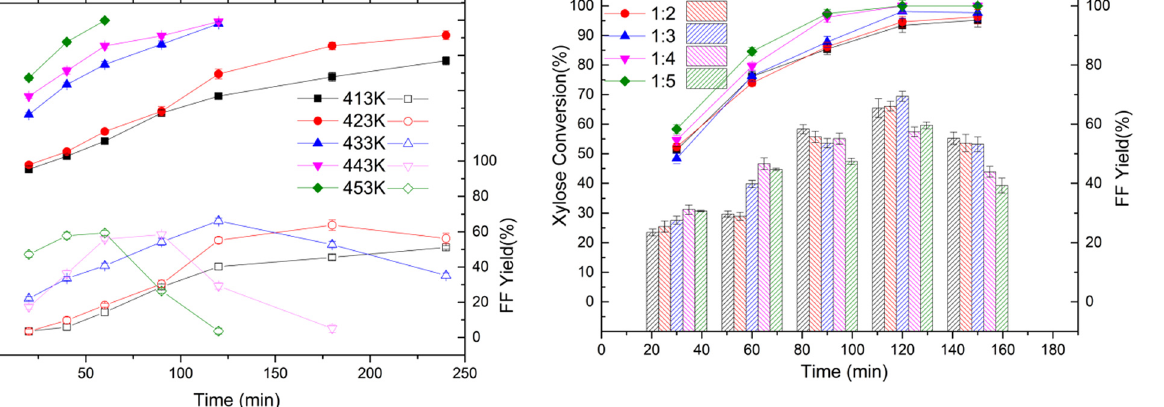
Figure 7: E ff ect of temperature on the conversion from xylose to FF. Reaction conditions: 150 mg G/F - 1/4, 5 mL water, 750 mg xylose.